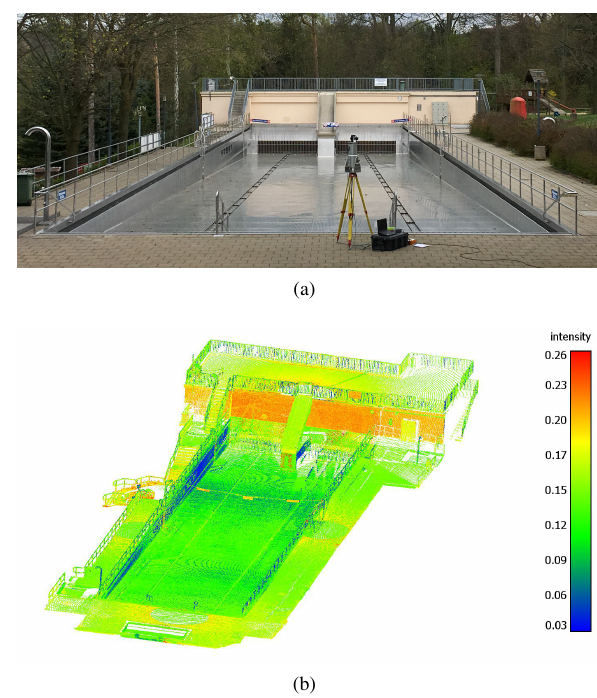
Figure 2. Empty wave pool (a) and intensity coded reference point cloud (b) acquired by terrestrial laser scanning.